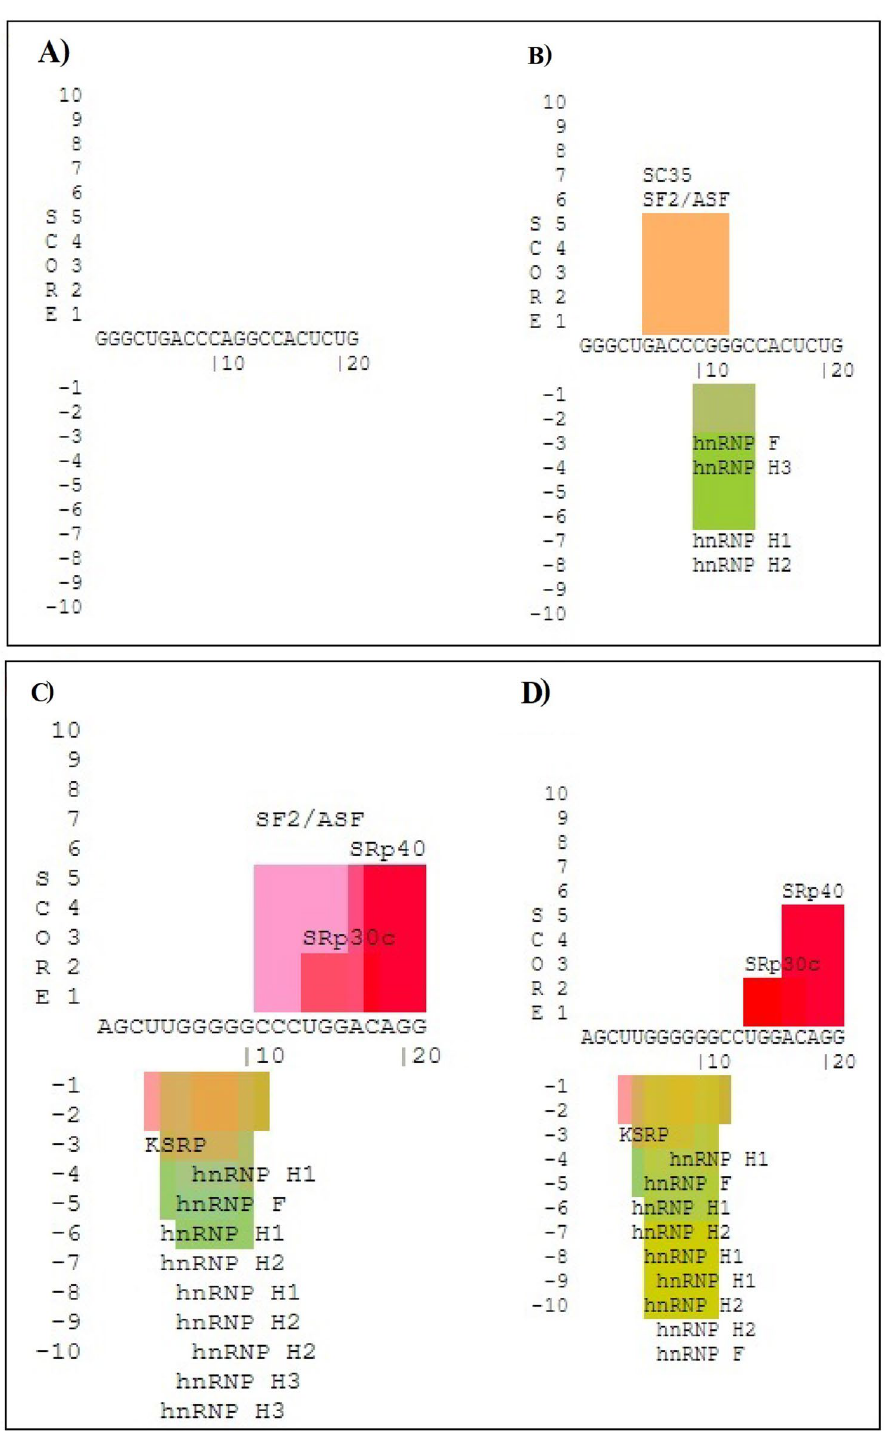
Figure 3. Web-based analysis of the impact of studied intronic variants on the pattern of splicing processes using the SpliceAid database. rs3731864 mutant ( A ), rs3731864 wild-type ( B ), rs3731865 mutant ( C ), rs3731865 wild-type ( D ). G to A substitution in the rs3731864 position disrupts the binding sites of some splicing factors including SC35, SF2/ASF, hnRNP f, hnRNP H3, hnRNP H1, and hnRNP H2. On the contrary, nucleotid change on the position of rs3731865 creates binding site for SF2/ASF and hnRNP H3